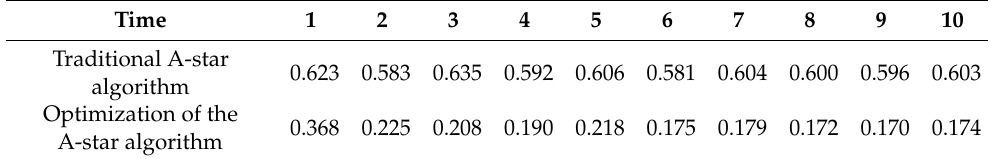
Table 1. Comparison of path-planning times based on Figure 8a,b (unit: s).